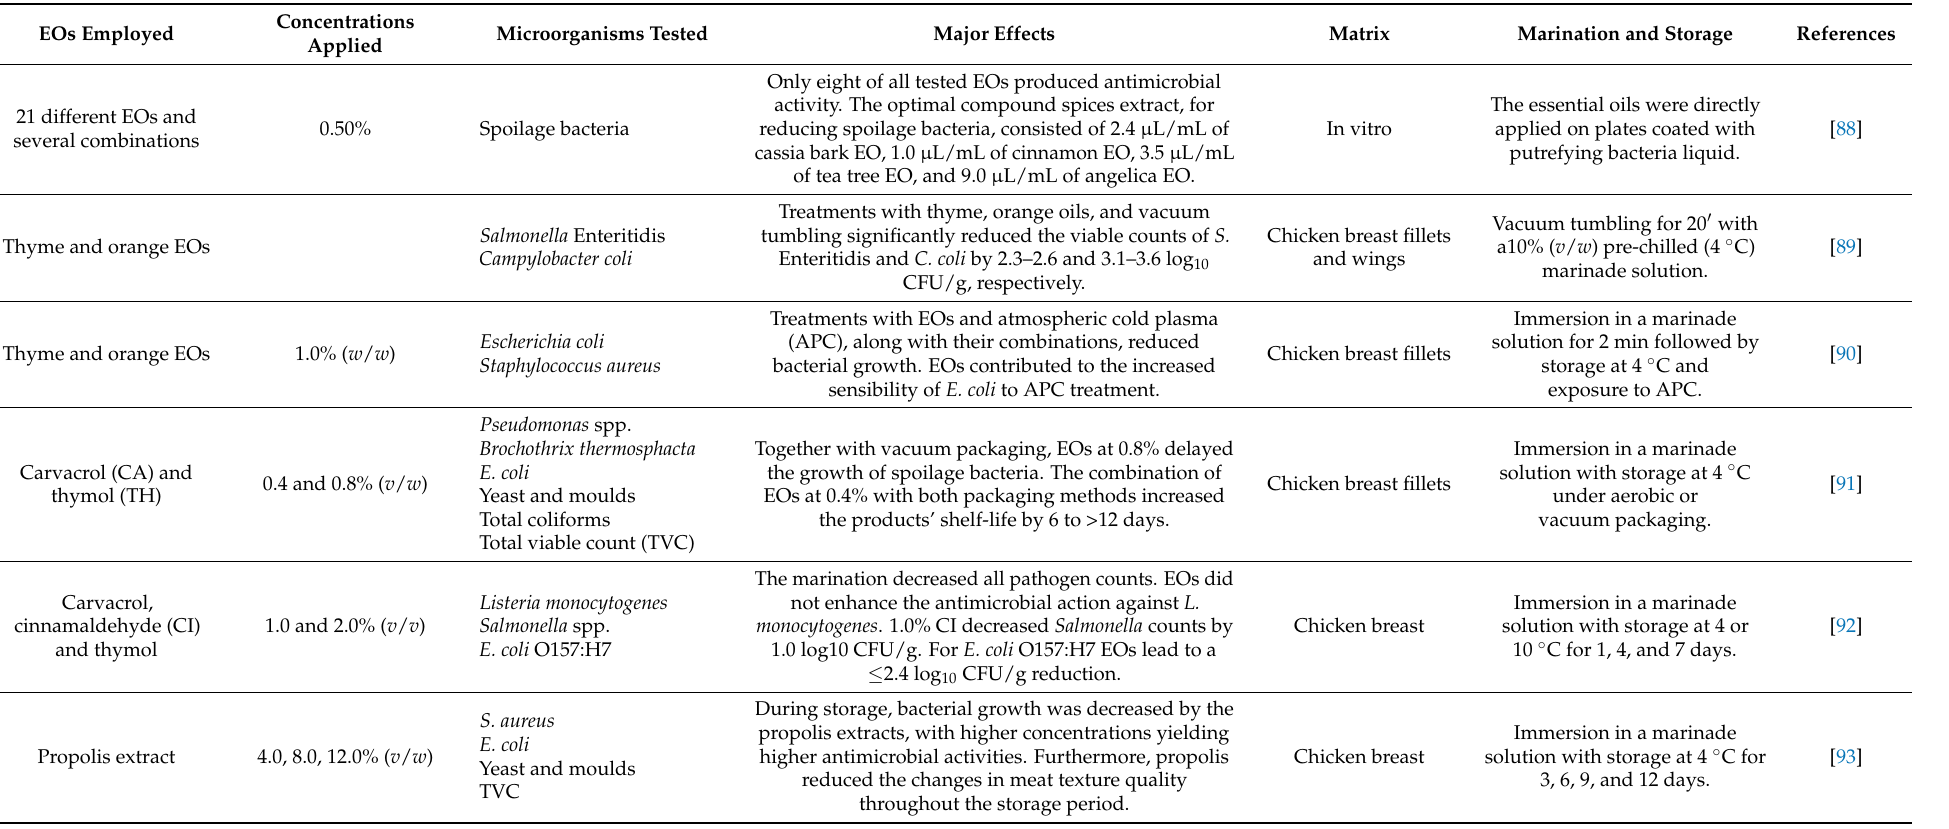
Table 2. Studies evaluating the antimicrobial activity of essential oils (EOs) of different